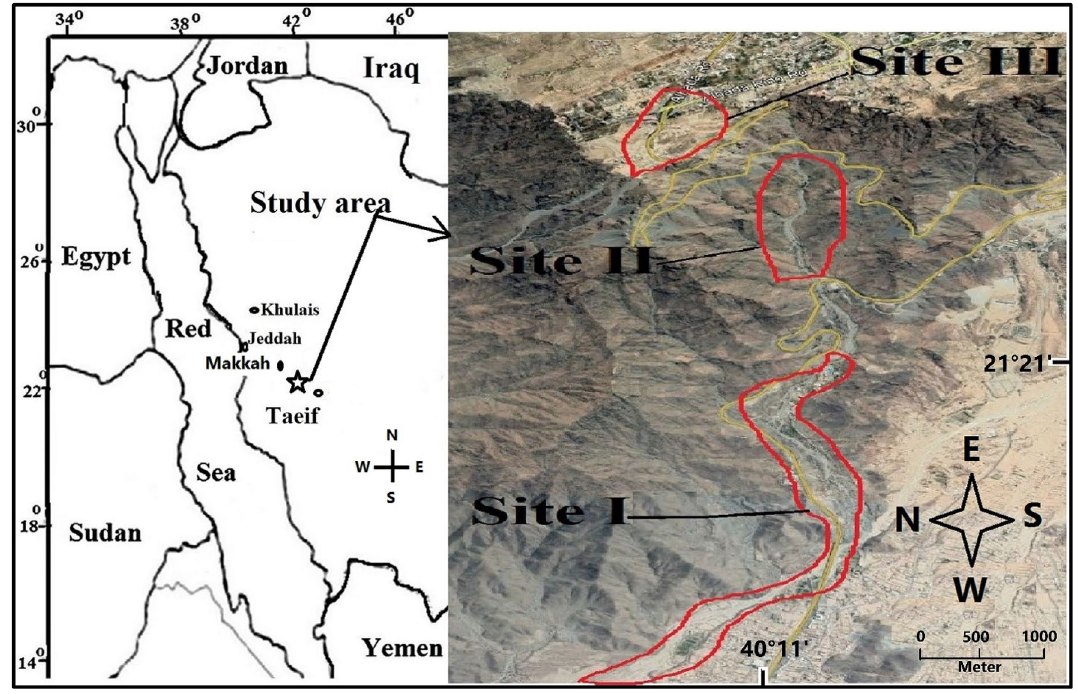
Figure 1. Diagram of the studied three sites (Image modified from the URL: https:// www. google. com/ maps/@ 21. 38567 6,40. 25157 76,11109m/ data=